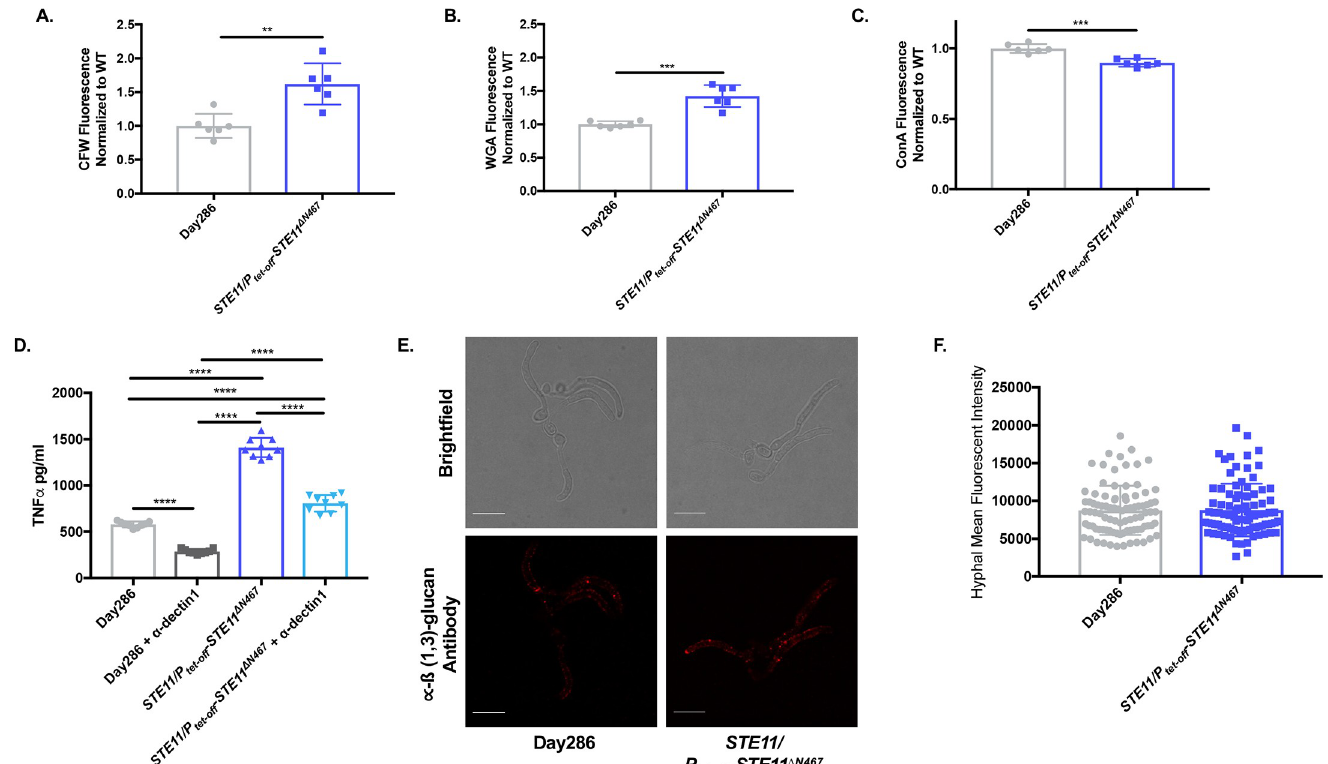
Fig 3. Hyperactive STE11 Δ N467 expression induces changes in cell wall components of yeast, but not hyphal cells of C . albicans . (A-C) Overnight cultures of Δ N467 cells grown in YPD without doxycycline were stained with calcofluor white (CFW), fluorescein conjugated wheat Day286 wild-type and STE11/P tet-off -STE11 germ agglutinin (WGA) and Alexa Fluor 647 conjugated concanavalin A (ConA) to assess total chitin, surface exposed chitin, and mannan, respectively. Three biological replicates with 2 technical replicates were run for each sample. (A) CFW staining, (B) WGA staining and (C) ConA staining. ( �� p < 0.005, ��� p < 0.0005, by student’s t-test). (D) The impact that dectin-1 recognition of exposed ß(1,3)-glucan has on macrophage activation was assessed via antibody blocking using an anti- Δ N467 cells were co-incubated for dectin-1 monoclonal neutralizing antibody. RAW264.7 macrophages and UV-inactivated Day286 wild-type or STE11/P tet-off -STE11 4 hours at a multiplicity of infection (M.O.I.) of 10. Prior to infection, macrophages were either pretreated with 5ug/ml of the anti-dectin-1 neutralizing antibody or a corresponding volume of tissue culture media lacking the antibody. Following co-incubation with yeast cells, supernatants were collected and filtered through a 0.22 μ m filter and secreted TNF α levels were determined via an ELISA. ( ���� p < 0.0001, by one-way ANOVA with Tukey’s post hoc analysis). (E-F) Hyphal cells of the Day286 wild-type and the STE11/P tet-off -STE11 Δ N467 strain were stained with anti-ß(1,3)-glucan antibody and a Cy3-conjugated secondary antibody for microscopic analysis of hyphal ß(1,3)-glucan unmasking. (E) Representative confocal microscopy image of stained hyphal cells. The scale bar indicates 10 μ m. (F) Quantification of hyphal immunofluorescence via ImageJ analysis (n = 3 independent replicates for each strain with 30 hyphal cells quantified per replicate)(p = 0.9258, by student’s t-test).